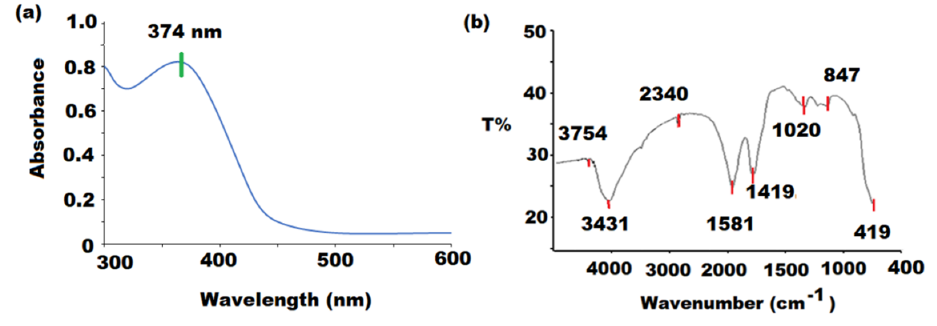
Figure 2. ( a ) UV-Vis and ( b ) FT-IR spectra of ZnONPs at 374 nm and 4000 to 400 cm −1 . The formation of ZnONPs was further confirmed by TEM and SEM